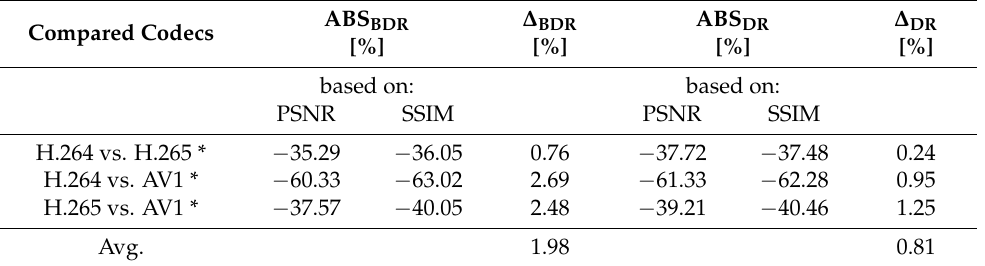
Table 5. Bitrate savings for the ‘Beauty’ video footage.